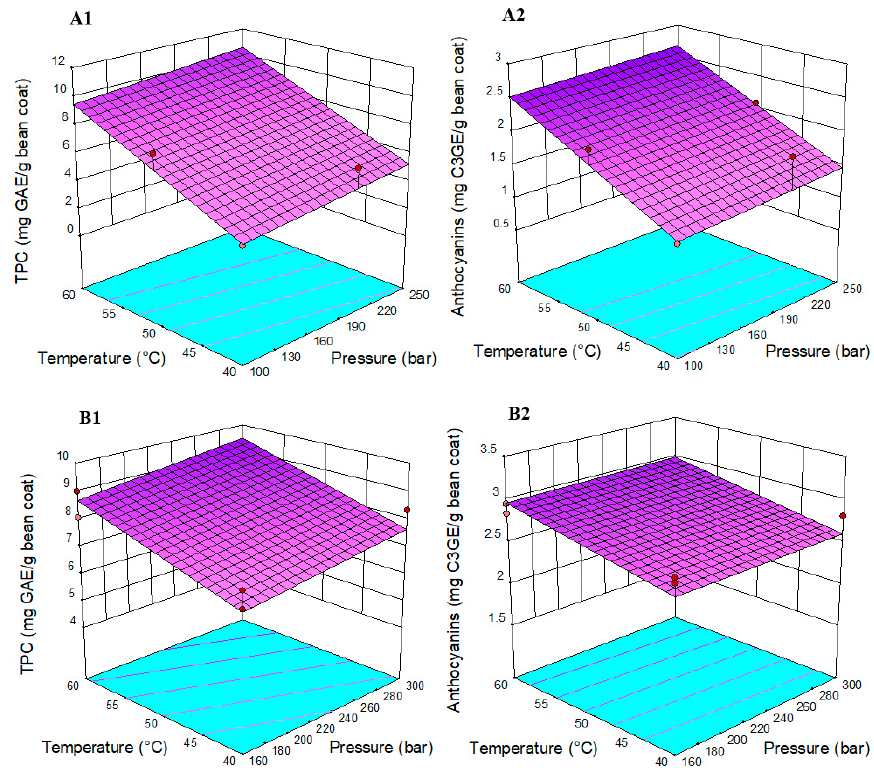
Figure 1. Response surface model for ( A ) Pressurized Liquid Extraction and ( B ) Supercritical Fluid Extraction, showing the effects of temperature and pressure on (1) anthocyanins and (2) total phenolic compounds. C3GE: Cyanidin 3-glucoside equivalents, GAE: Gallic acid equivalents.